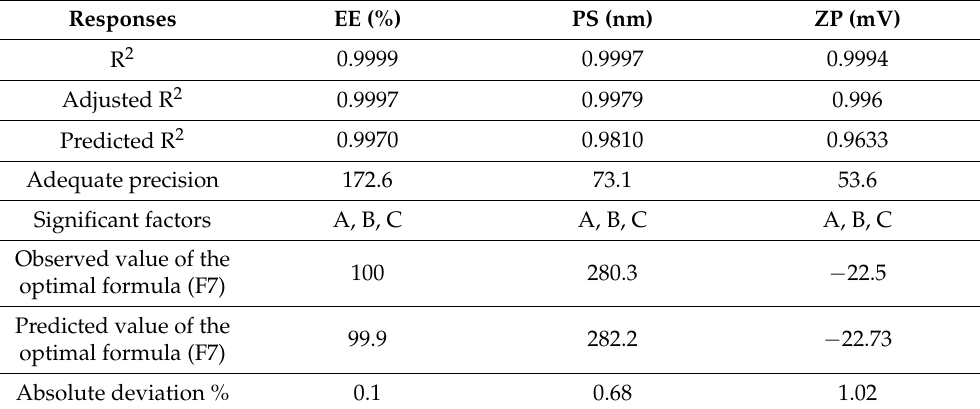
Table 3. 2 3 output factorial analysis data of 4e-loaded PEGylated bilsomes and the predicted and observed responses and deviation percent of the optimum formula (F7).